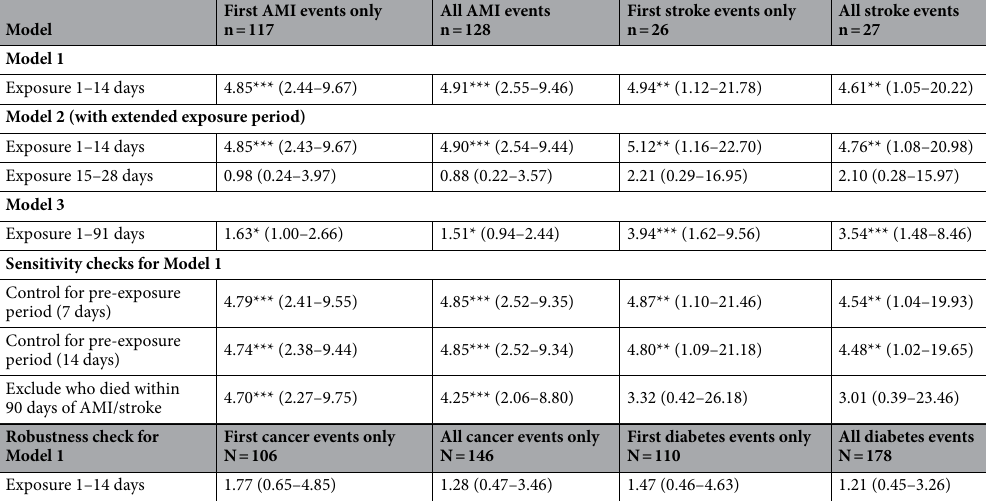
Table 2. Relative incidence ratios (RIR) for AMI/stroke after LRTI exposure with sensitivity/robustness checks. ***Significant at 1%; **significant at 5%; *significant at 10%.